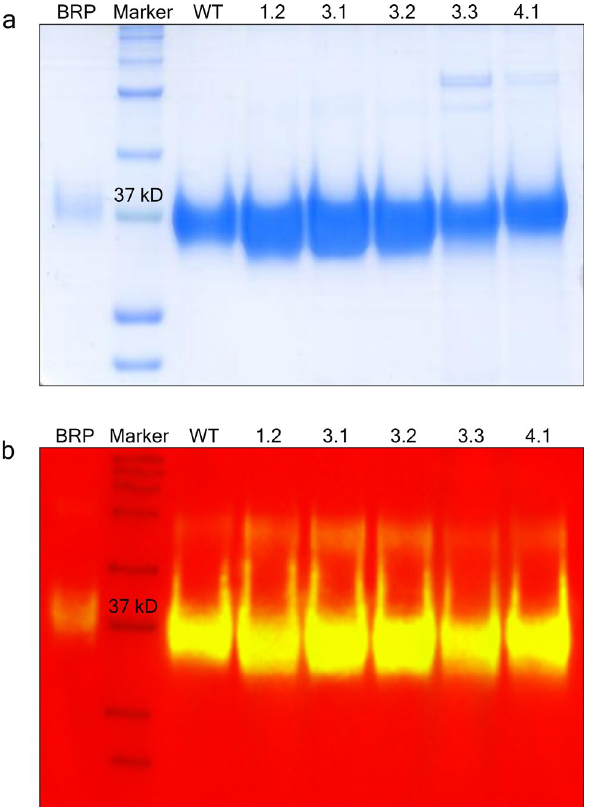
Figure 2. Coomassie blue stained gel ( a ) and Western immunoblotting ( b ) of the EPO proteins. EPO standard, wild type and mutant proteins were separated according to their molecular mass in 12% SDS polyacrylamide gel at a constant 175 voltages for 1.5 h. ( a ) The purity of separated proteins was visualized by Coomassie blue staining. The gel image was taken using HP LaserJet scanner. ( b ) The identity of EPO antigen was detected by Western immunoblotting. The chemiluminescence signals of protein samples were detected and the image was taken using ImageQuant LAS 4000 control software version 1.2 provided with ImageQuant LAS 4000 machine at the exposure time of 1 s. The signals were then overlaid with the marker using ImageQuant TL software version 7.0 (https ://www.cytiv alife scien ces.com/en/us). The native gel and blot are presented in Supplementary Figs. S1 and S2, respectively. BRP, EPO standard; Marker, Precision Plus Protein Kaleidoscope Prestained Protein Standards; WT, EPO-WT; 1.2, EPO-1.2 (L70V, V74L, L102I); 3.1, EPO-3.1 (T106A); 3.2, EPO-3.2 (T106G); 3.3, EPO-3.3 (T106H); 4.1, EPO-4.1